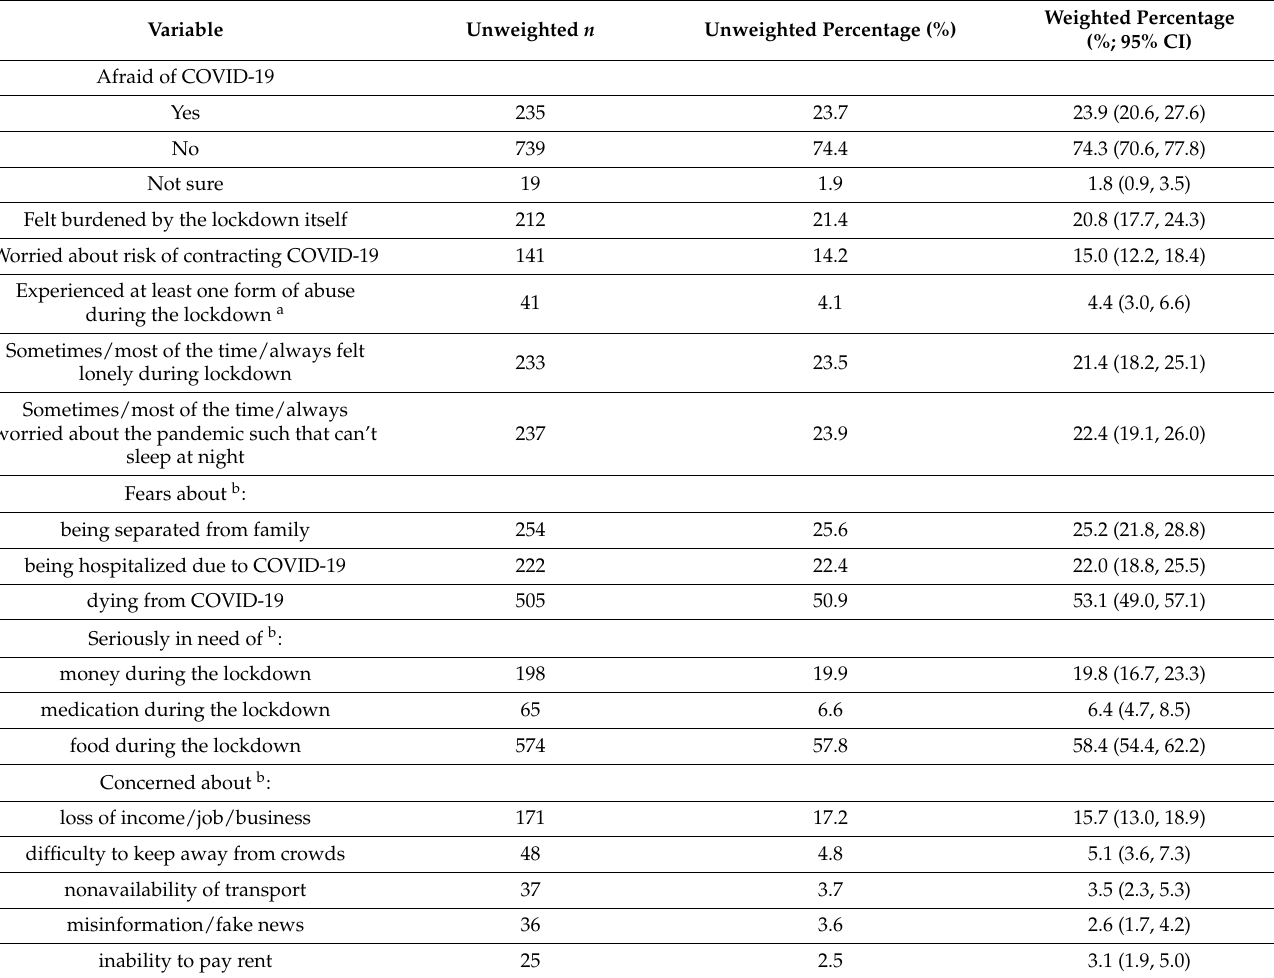
Table 3. COVID-19-related stressors among adults in Eswatini (unweighted N = 993, weighted N =